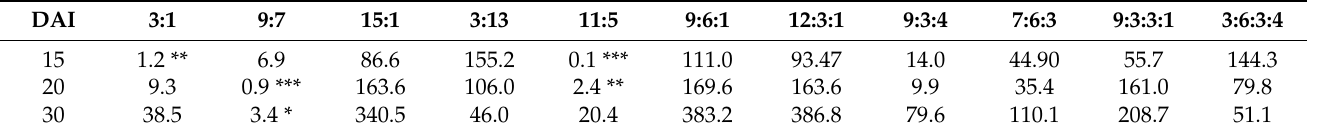
Table 3. Segregation of R. solanacearum SL1931 resistance in F 2 population at 15, 20, and 30